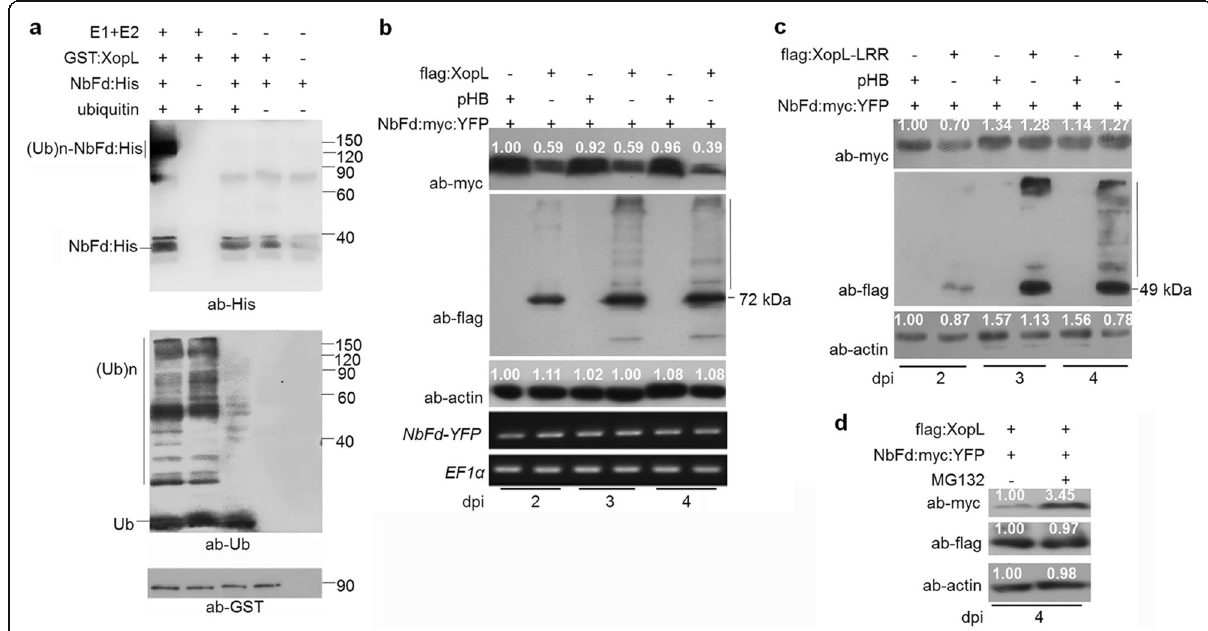
Fig. 4 XopL mediates the ubiquitination and degradation of NbFd. a In vitro assay for XopL-mediated ubiquitination of NbFd. Anti-His antisera (ab-His) was used to detect His-tagged NbFd or its ubiquitinated products, anti-ubiquitin antibody (an-ub) was used to detect ubiquitin or polyubiquitin, and anti-GST antibody (ab-GST) was used to detect XopL. The experiment was repeated three times with similar results. b XopL mediates NbFd degradation in planta . NbFd was detected with anti-myc antibody at 2, 3 and 4 dpi. XopL was detected using anti-flag antisera, and total protein was monitored with anti-actin antibody. mRNA of transiently expressed NbFd-YFP and native EF1 α were measured at each time interval by RT-PCR. c LRR domain of XopL fails to mediate NbFd degradation. NbFd:YFP and pHB-xopL-LRR (lacking E3 ligase domain) or empty pHB were agroinfiltrated into Nb. NbFd, XopL-LRR, and actin levels were measured by immunoblotting as described in panel b. d Effect of the proteasome inhibitor MG132 on the stability of ferredoxin. Anti-flag and actin antibodies were used to detect flag-tagged XopL and actin respectively. In panels b, c, and d, the values above each blotted band represent band intensity and were calculated using Image J software. In each panel, the first lane band intensity was normalized as 1.00. Experiments were repeated at least three times with similar